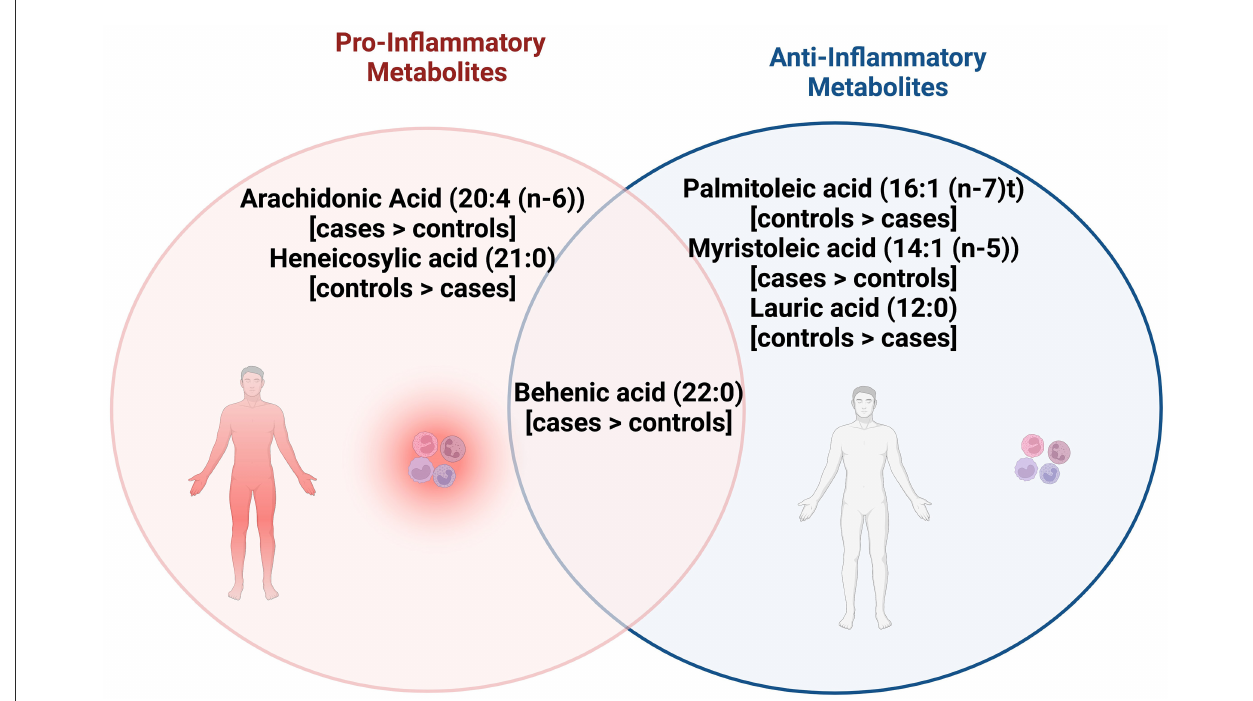
FIGURE2 Venn diagram shows the pro and anti-inflammatory fatty acid metabolites that were significantly different between cases and controls, with behenic acid, arachidonic acid, and myristoleic acid observed to be higher in cases while palmitoleic acid, lauric acid, and heneicosylic acid were higher in controls. Behenic acid appears to have both pro and anti-inflammatory actions while arachidonic acid and heneicosylic acid have pro-inflammatory actions. Palmitoleic acid, myristoleic acid, lauric acid appear to have anti-inflammatory